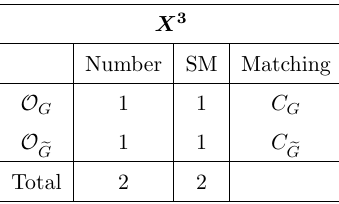
Table 12 . Dimension-six triple-gauge-boson operators in LEFT. The tree-level matching coefficient of each operator is equal to the coefficient of the corresponding operator in SMEFT.